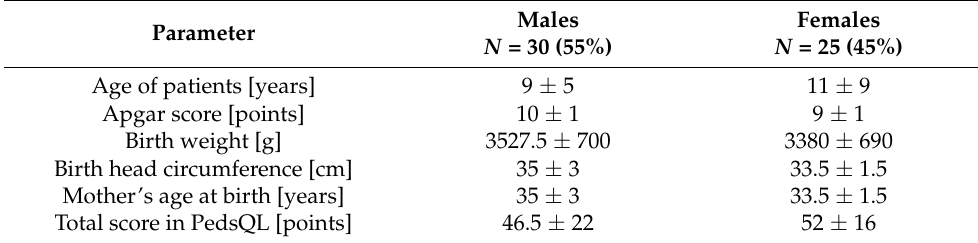
Table 1. Median and IQR of the parameters.